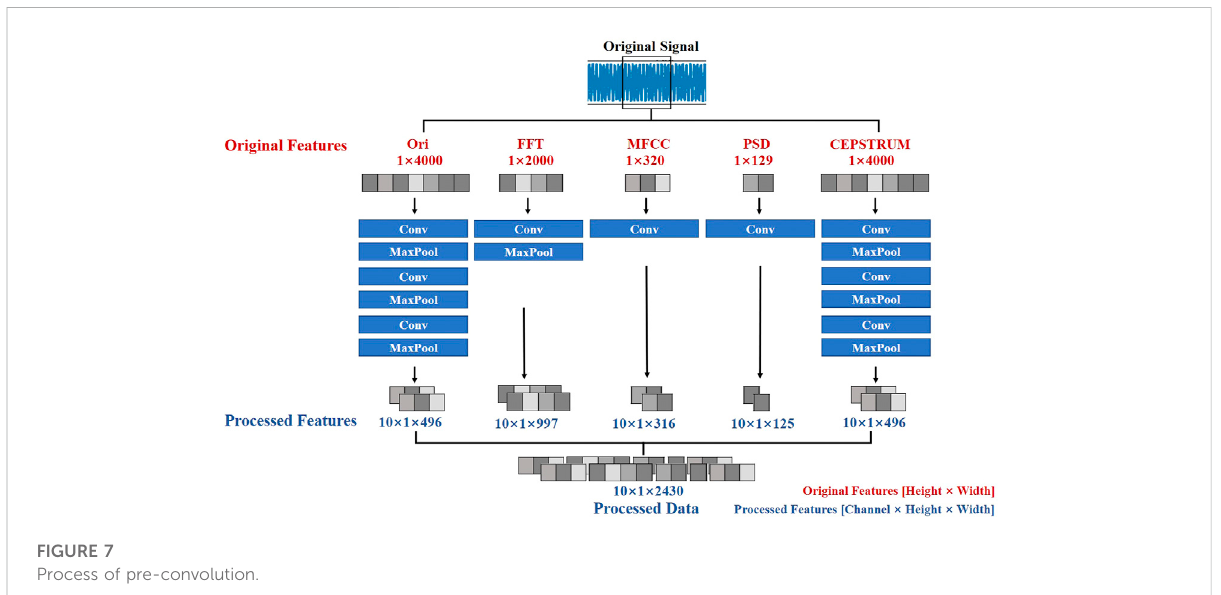
FIGURE 7 Process of pre-convolution.